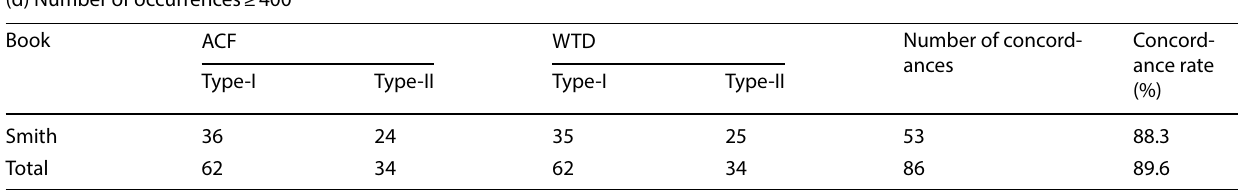
Fig. 8 Asymptotic change of concordance rates. The concordance rates are also shown in the bottom lines of Table 3(a)–(d) and are calculated as the total number of concordances divided by the number of all words under given conditions of occurrence